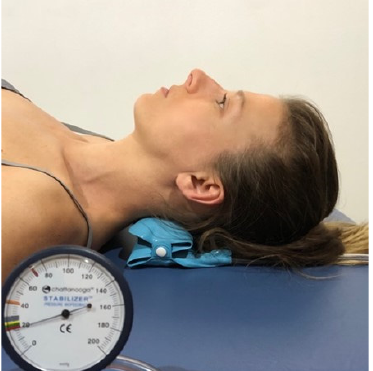
Figure 1. Craniocervical flexion test.